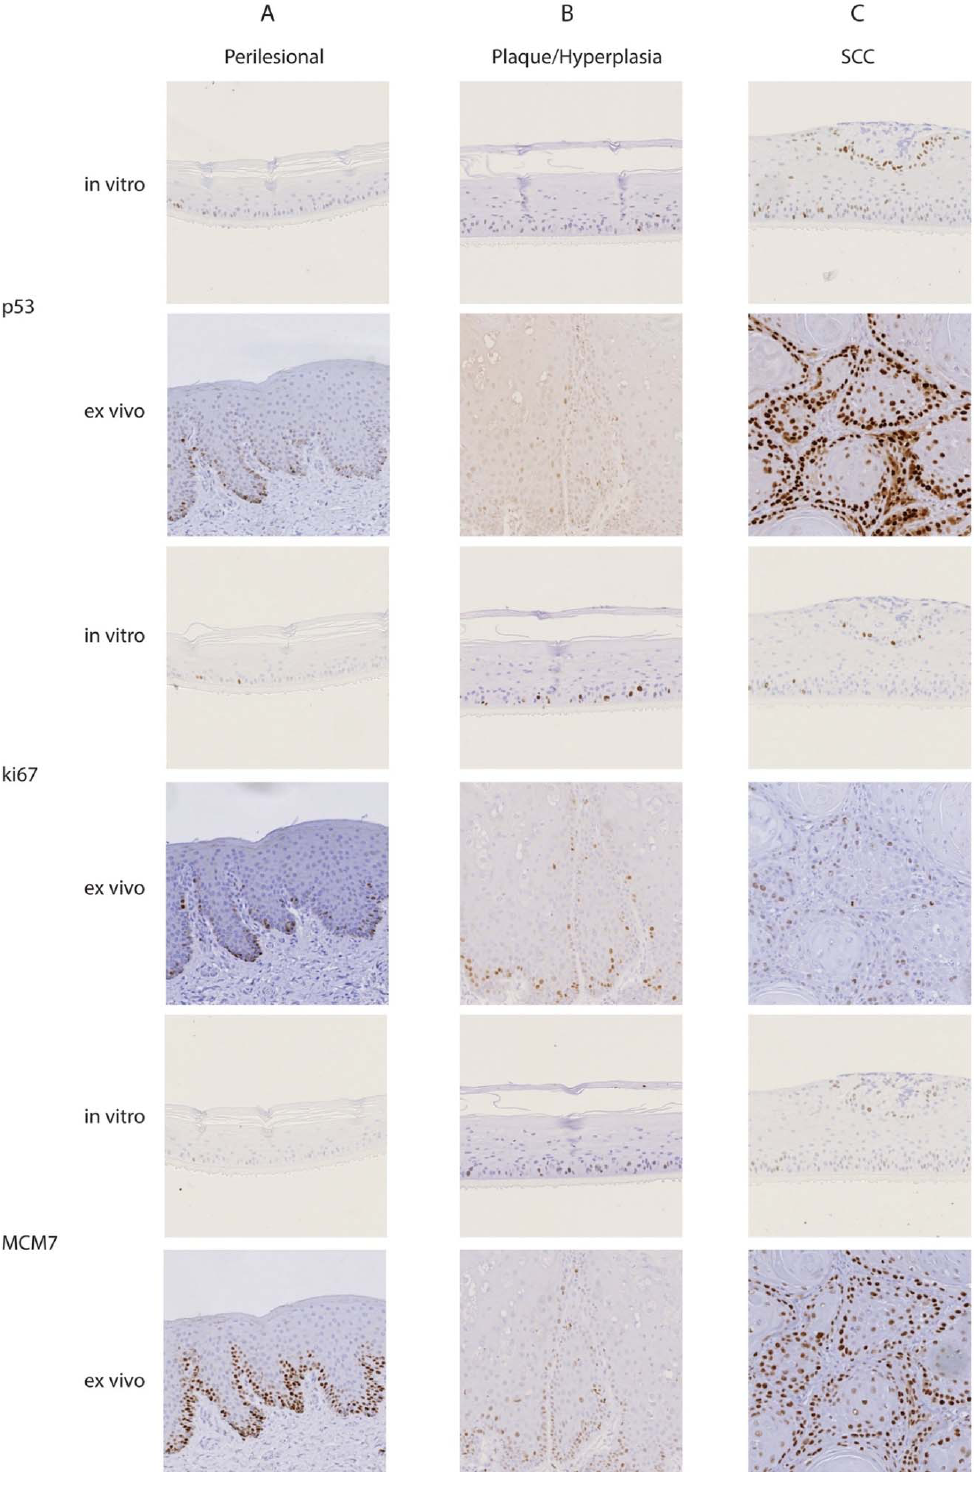
Figure 3. p53, Ki67 and MCM7 immunostaining of raft cultures and corresponding tissue sections. Immunostaining using p53, Ki67 and MCM7 antibodies of representative areas of perilesional ( A ), plaque/hyperplasia ( B ) and squamous cell carcinoma (SCC) ( C ) raft cultures and tissue sections. Expression of p53, Ki67 and MCM7 increases with increasing neoplastic phenotype within both rafts and tissue sections of EcPV2-associated lesions. All photographs taken using 10 ×